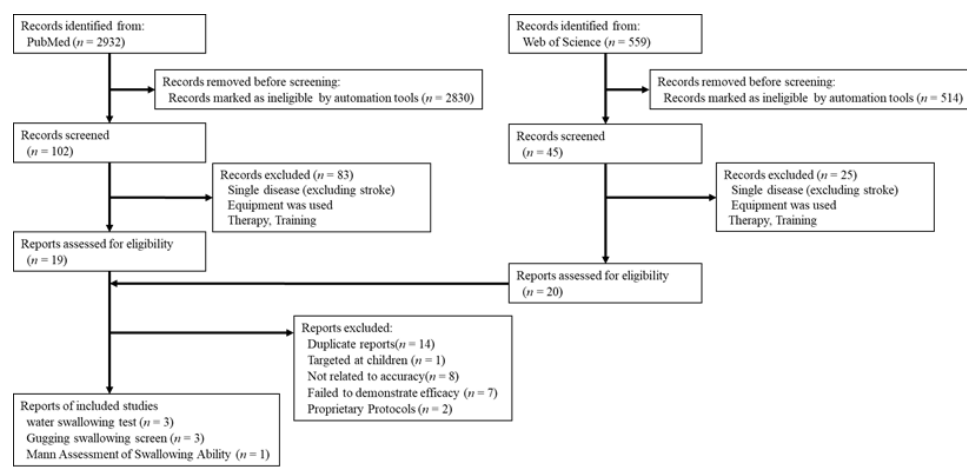
Figure 1. Study selection flowchart.